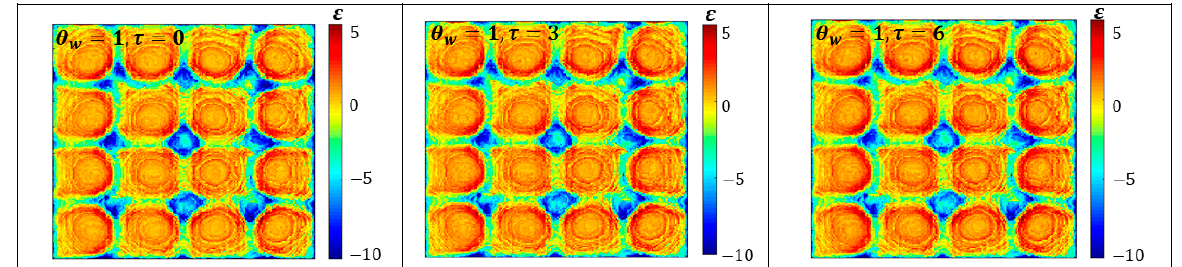
Figure 7. Method A, Case III: Local h variation with x* at y* = 0.375 and y* = 0.5 (see Figure 1) and their relative % differences.